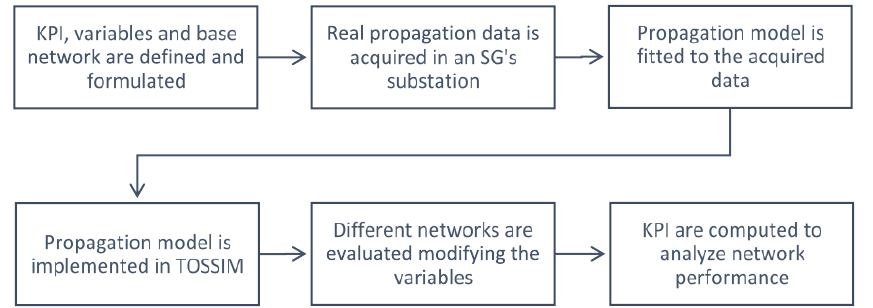
Figure 1. The six-step process followed to extract the propagation data, model the environment, define the network and finally, simulate and evaluate